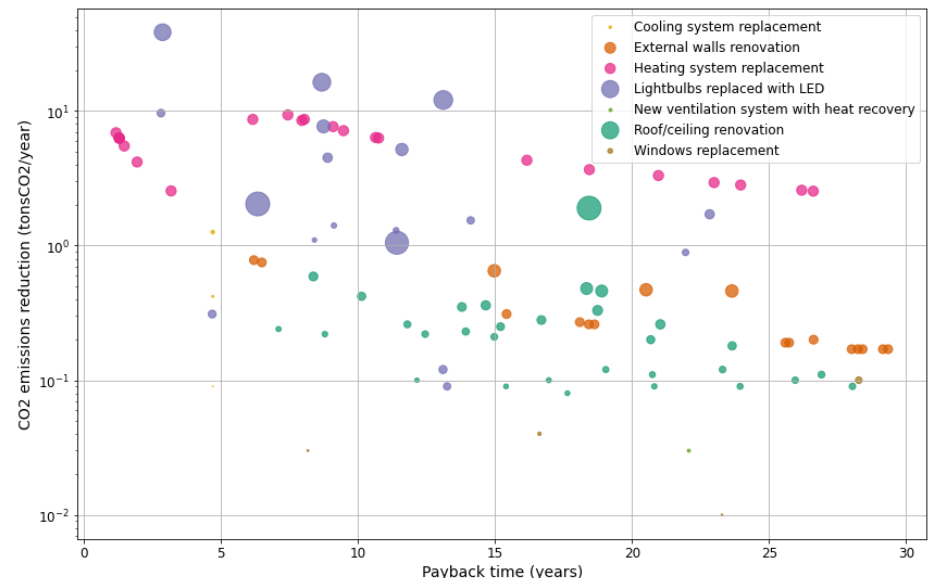
Figure 9. Payback time vs. CO 2 emission savings of the selected actions to improve energy efficiency and renewable energies in the buildings. The circle size represents the investment of the measure.